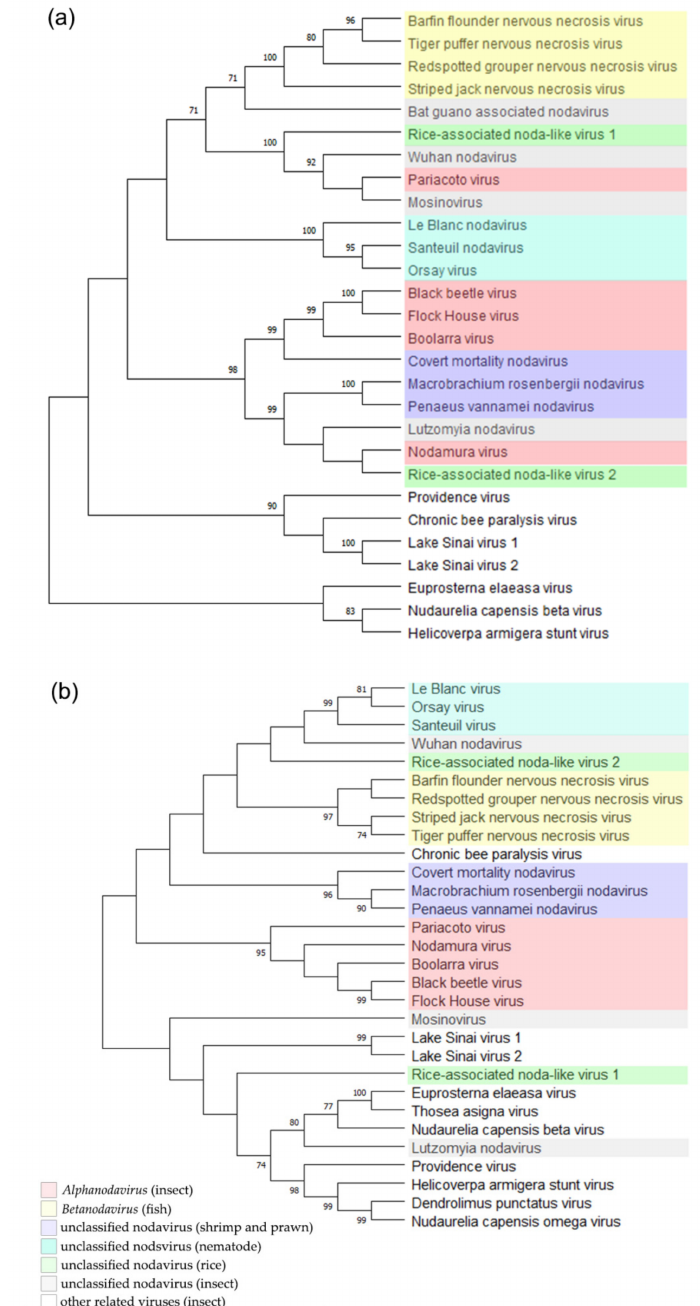
Figure 3. Phylogenetic relationships between RNLV1, RNLV2, and other related viruses. The phylogenetic trees were constructed using the RdRp sequences ( a ) or the CP sequences ( b ) and the maximum likelihood method with 1000 bootstraps. Accession numbers of these sequences are listed in Table S3. The bootstrap values are indicated adjacent to the nodes. Taxonomy and hosts of these analyzed viruses are